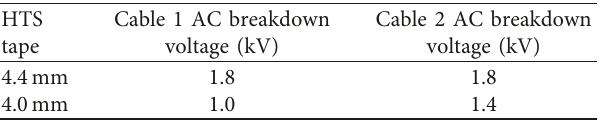
Table 3: AC breakdown measurements of heat shrink model